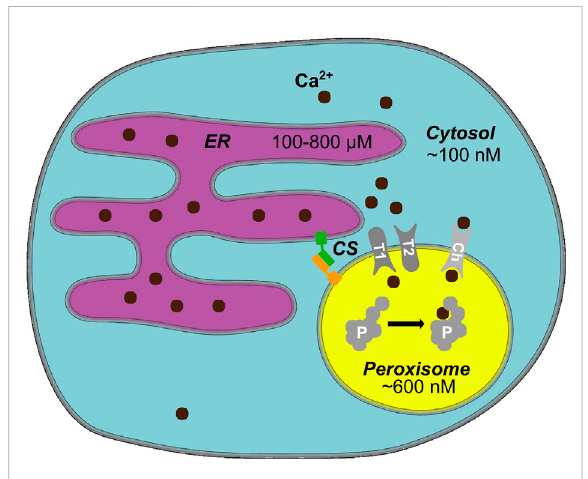
FIGURE 1 Peroxisomal Calcium — an Overview. In mammalian cells, cytosolicCa 2+ levelsarearound100 nM,whereastheendoplasmic reticulum (ER) as a main cellular Ca 2+ store has several hundred micromolar Ca 2+ (Samtleben et al., 2013). An average peroxisome contains around 600 nM Ca 2+ (Sargsyan et al., 2021). Ca 2+ likely enters peroxisomes either through a channel/pore or a transporter (Ch). The entry and exit mechanism of Ca 2+ , however, may differ (T1/T2 hypothetical importer/exporter). Known protein tethers form contact sites (CS) between peroxisomes and the ER, potentially create microdomains that facilitate the exchange of Ca 2+ . Ca 2+ may bind to a yet unknown intraperoxisomal protein (P) or membrane protein and affect its function, e.g., by inducing a conformational change when bound to Ca 2+ . Hypothetical elements of the model (channel, transporter, intraperoxisomal Ca 2+ -sensitive protein) are shown in